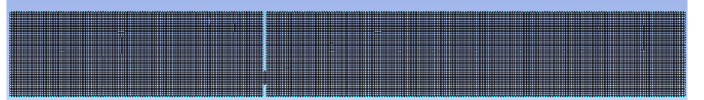
Figure 3. Two-dimensional roadway model.